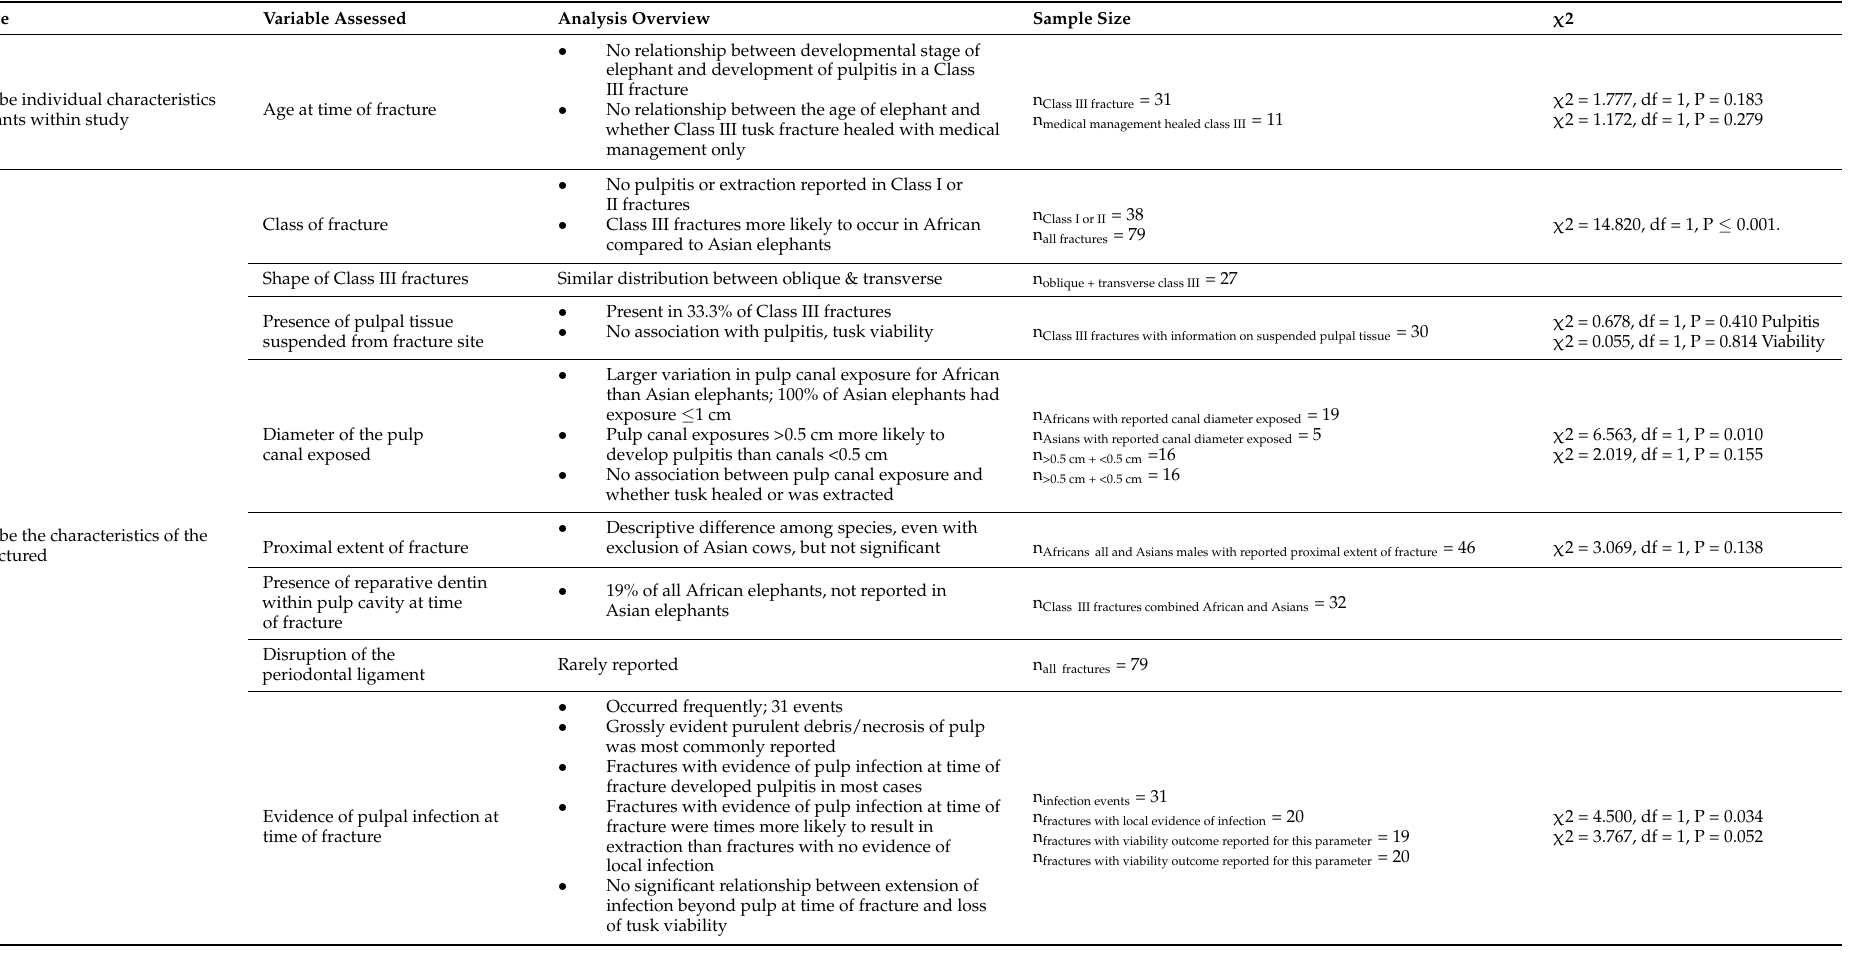
Table 4. Analysis highlights and statistics of selected variables, organized according to this study’s